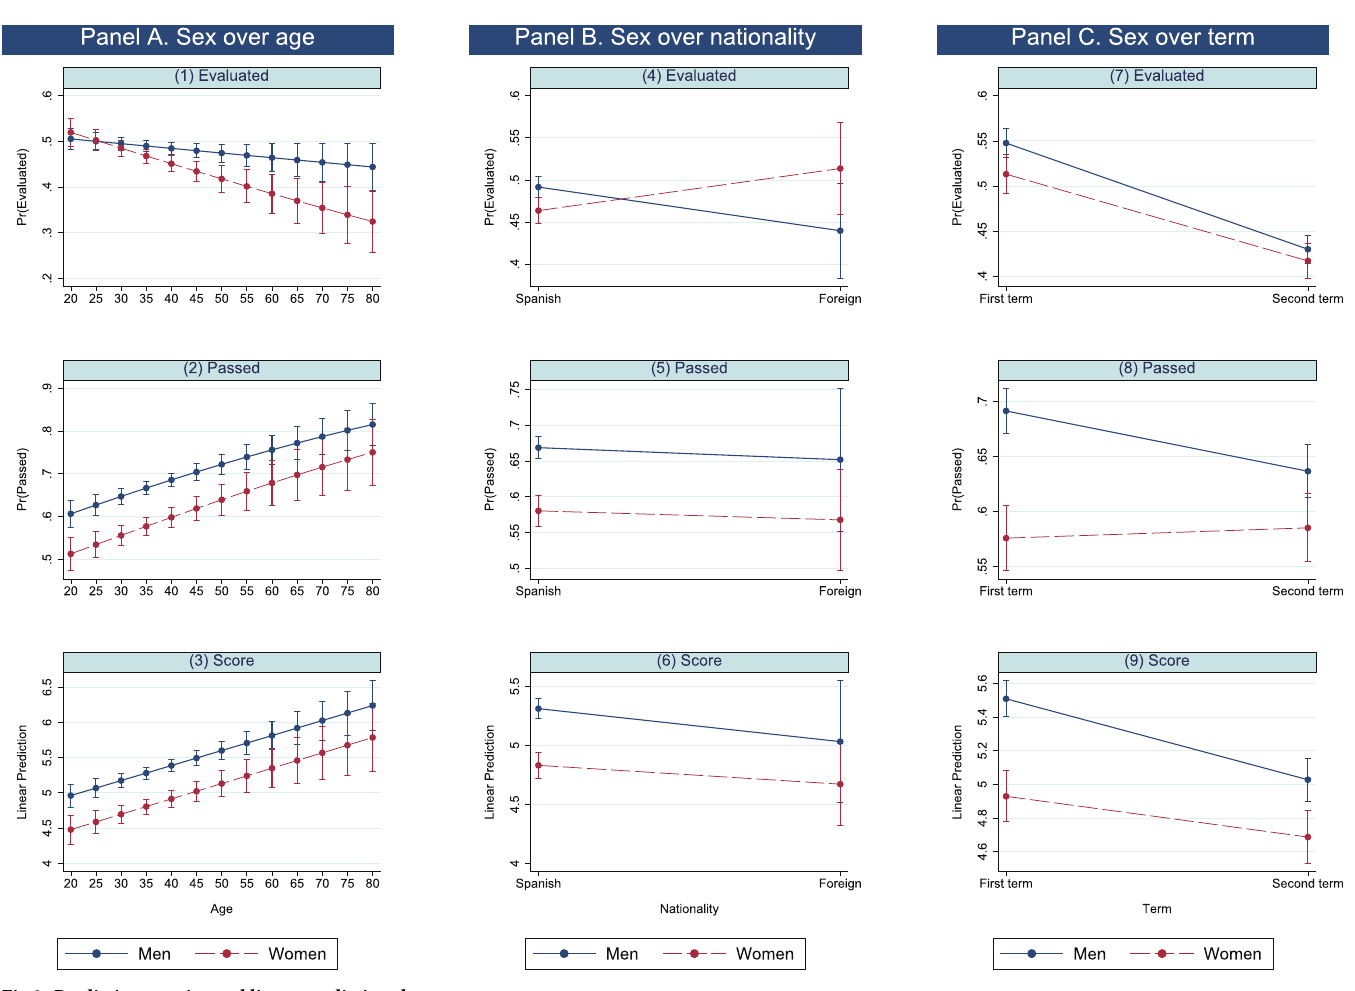
Fig 3. Predictive margins and linear predictions by